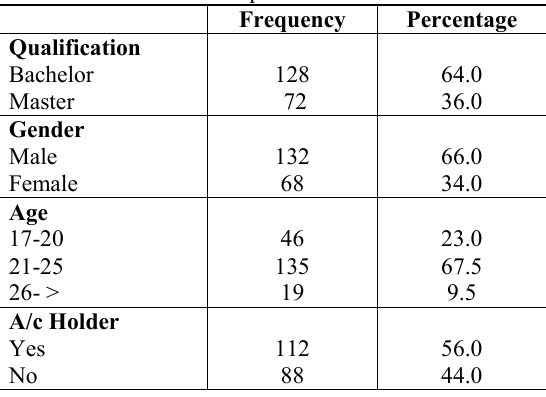
Table 1: Respondents’ Profile